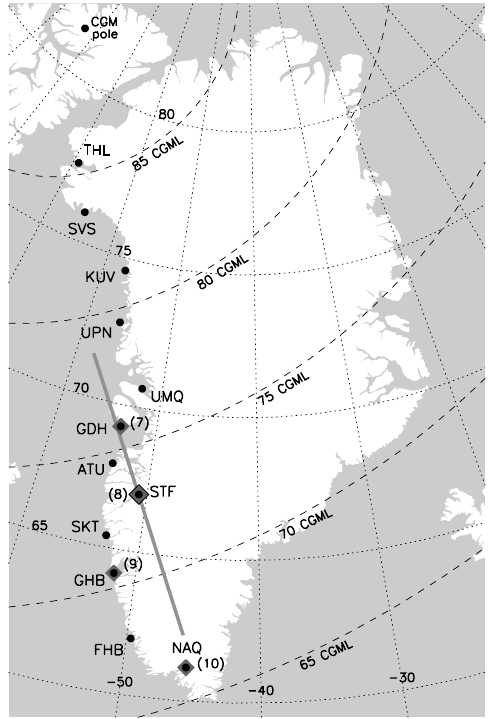
Fig. 1. Greenland with the magnetometer sites of the Danish Meteorological Institute, DMI (full black circles with three-letter station codes), the satellite receiver stations of the Applied Research Laboratories at the University of Texas, Austin, ARL:UT (full gray diamonds with numbers), and the Sondrestrom (STF) Incoherent Scatter Radar facility operated by SRI International (open black diamond). Geomagnetic latitude contours (dashed) are plotted in addition to geographic coordinates (dotted), and the ISR antenna scan trace at 350 km altitude is marked by a heavy